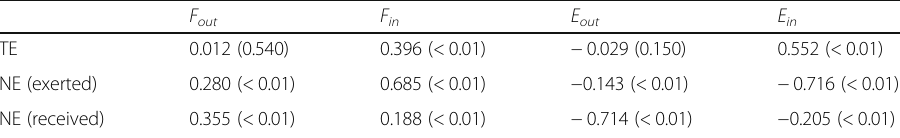
Table 7 Correlation coefficient between numbers of friend and enemy-nominating ties and the effects calculated from our methodology. Numbers in parenthesis are p -values for the significance of the corresponding correlation analysis F F E E out in out in TE 0.012 (0.540) 0.396 (< 0.01) − 0.029 (0.150) 0.552 (< 0.01) NE (exerted) 0.280 (< 0.01) 0.685 (<